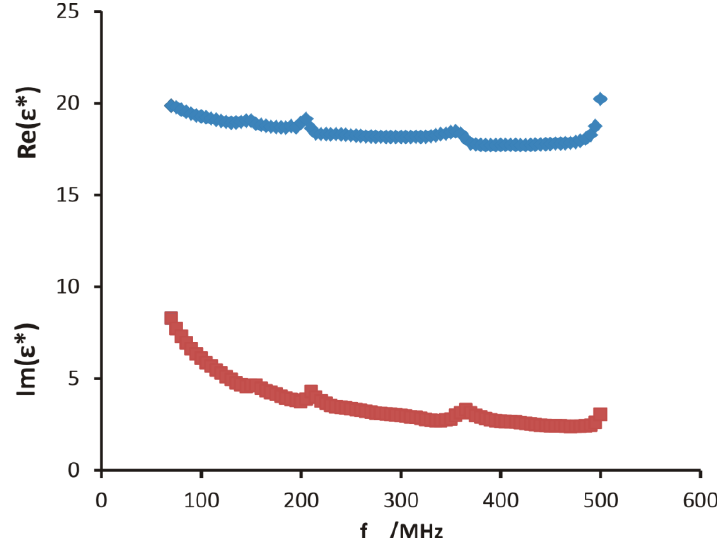
Figure 1. Real and imaginary parts of the complex dielectric permittivity of a sample of soil no. 601 wetted with distilled water to approximately 50% of saturation water